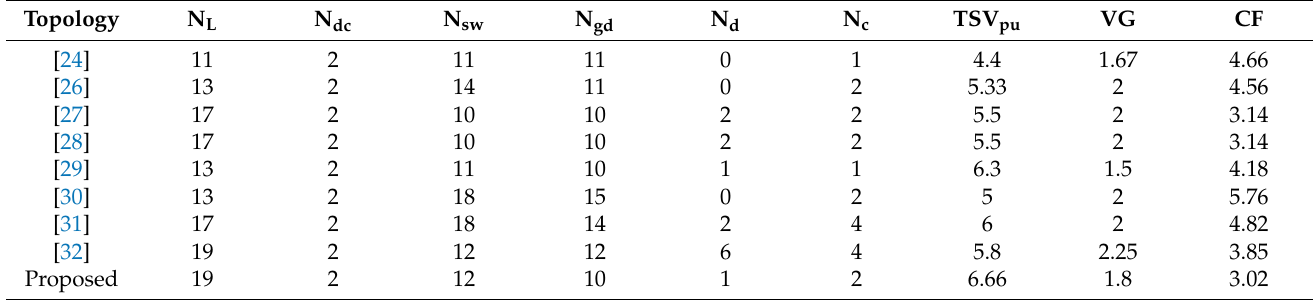
Table 2. Comparative